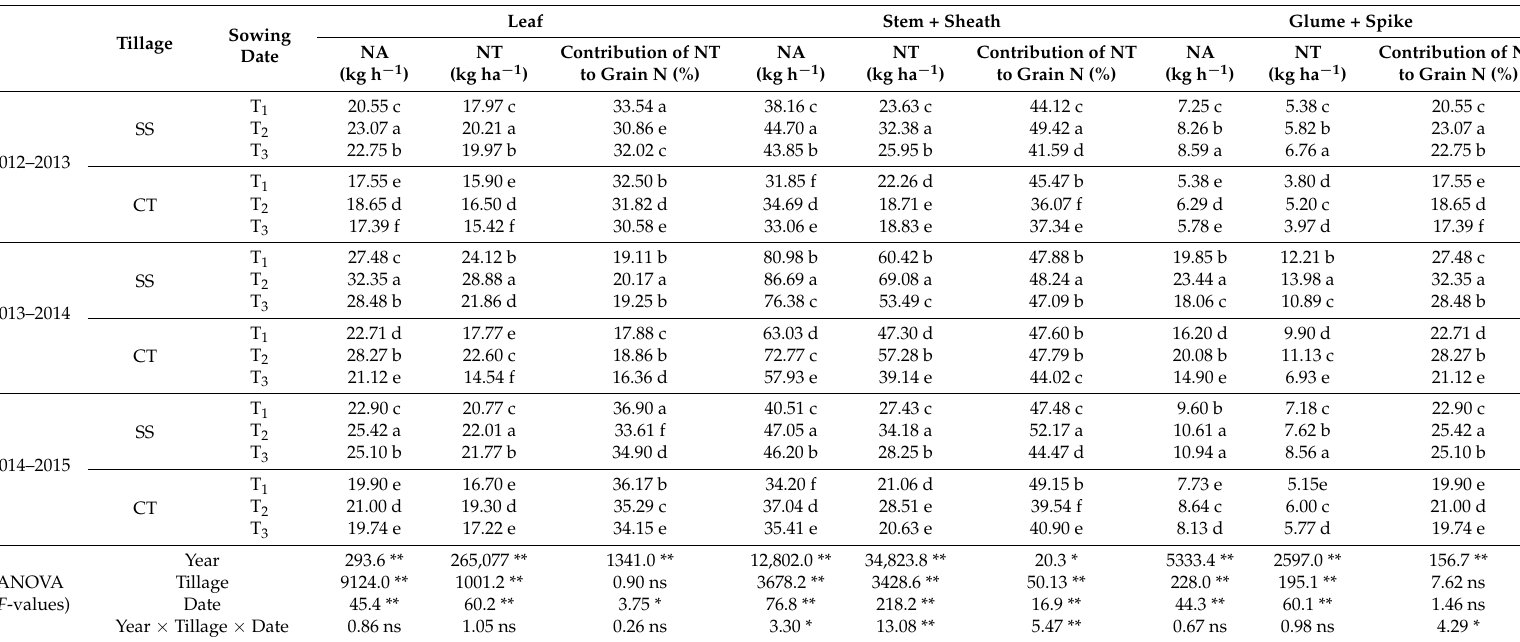
Table 3. Effect of subsoiling in the fallow period and different sowing date on nitrogen accumulation, translocation, and contribution ratio to the grains of wheat before